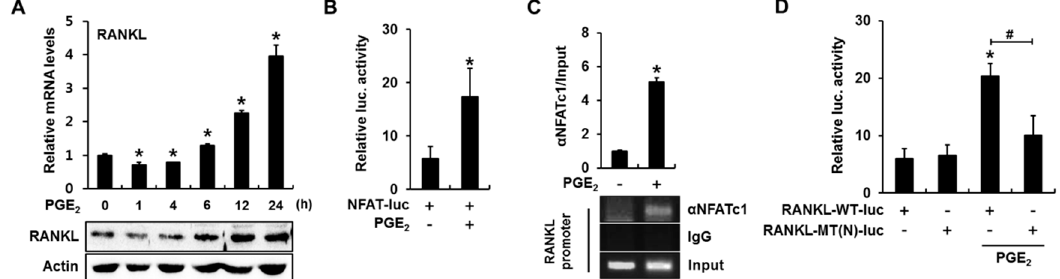
Figure 3. PGE 2 stimulates RANKL expression by activating the calcineurin/NFAT pathway in C2C12 cells. ( A ) PGE 2 increased RANKL expression in a time-dependent manner. C2C12 cells were incubated in the presence of PGE 2 (50 nM) for the indicated time periods, followed by quantitative RT-PCR and western blot analyses; ( B ) PGE 2 increased NFAT transcriptional activity. C2C12 cells were transfected with a reporter plasmid containing an NFAT response element, treated with PGE 2 for 24 h, and subjected to a luciferase assay; ( C ) PGE 2 induced NFAT binding to the mouse RANKL promoter. C2C12 cells were treated with PGE 2 for 24 h and a ChIP assay was performed; ( D ) PGE 2 increased RANKL promoter-reporter activity in an NFAT binding element-dependent manner. C2C12 cells were transfected with RANKL -WT-luc or RANKL -MT(N)-luc, incubated for 24 h in the presence of PGE 2 , and subjected to a luciferase assay (* p < 0.05, compared to control; # p < 0.05).